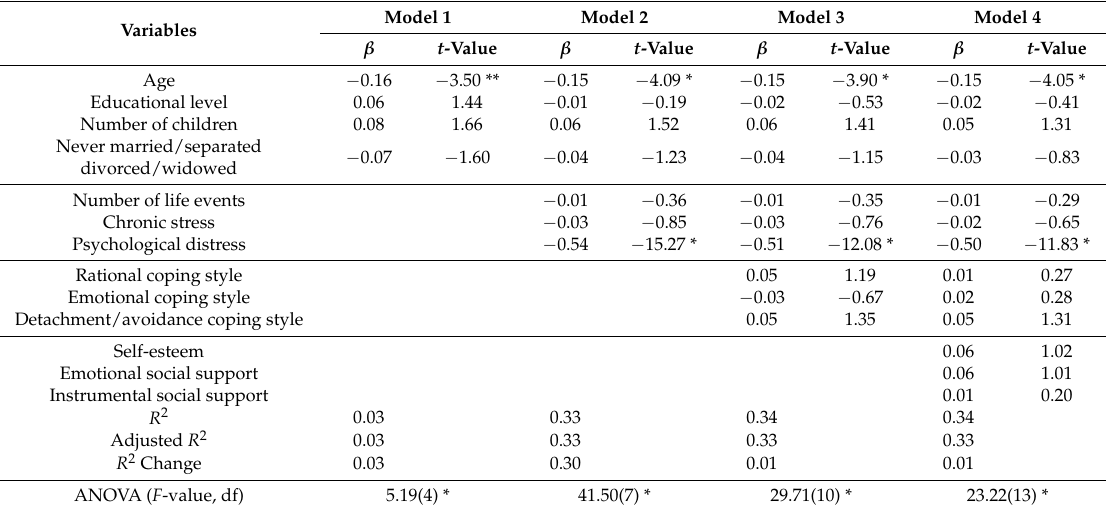
Table 5. Summary of the hierarchical regression with social functioning as the dependent variable for the men group.